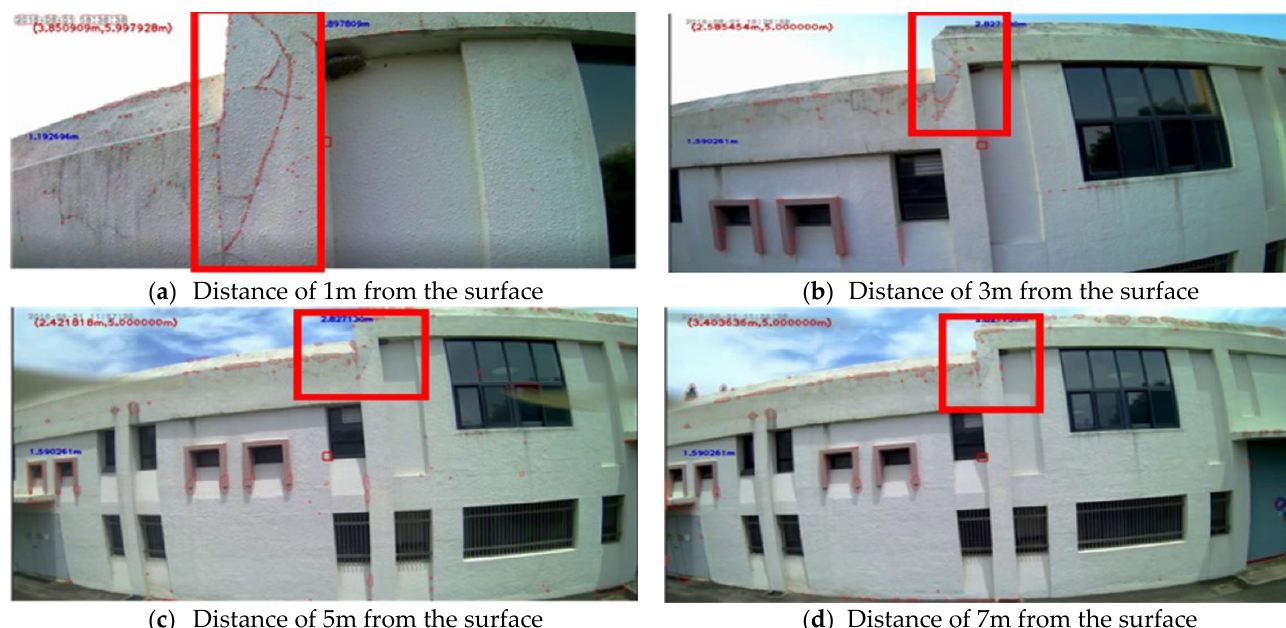
Figure 7. Detection results by distance ( a ) 1 m from the surface, ( b ) 3 m from the surface, ( c ) 5 m from the surface, and ( d ) 7 m from the surface. As the drone flies further away from the building, the distortion increases and the resolution of the crack